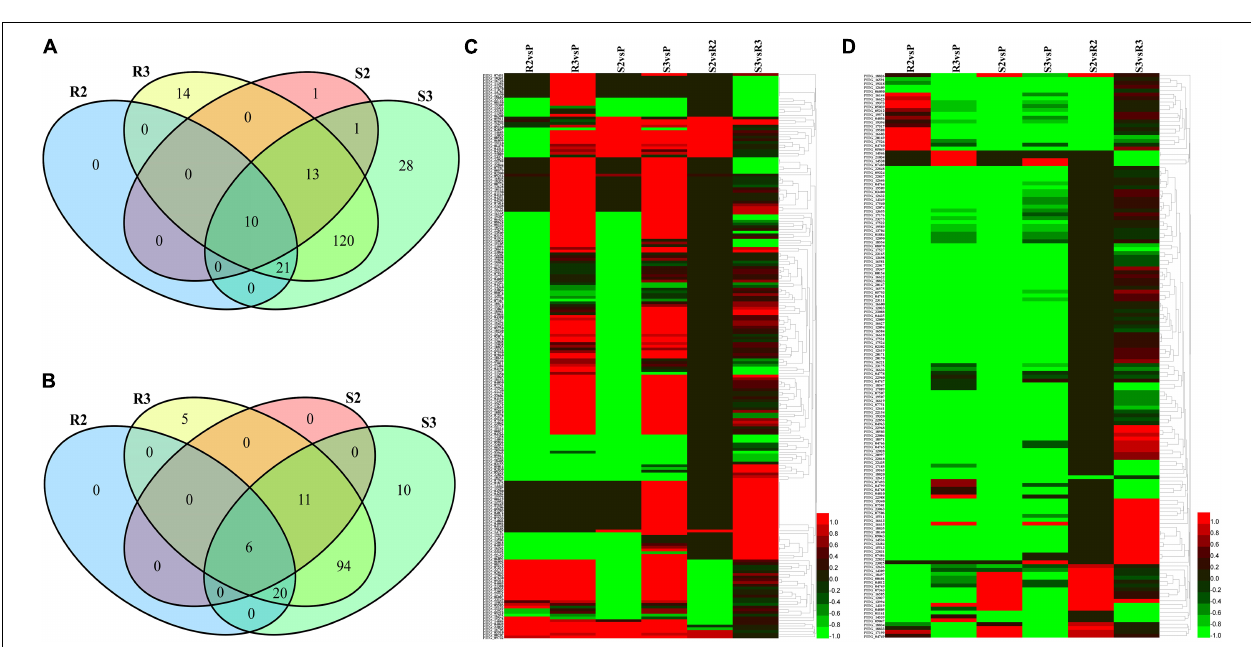
FIGURE 3 | Expression trend of the potato SEGs identified from incompatible interaction. The 1,180 SEGs were identified in Ziyun No.1 when compared with the susceptible cultivar Favorita. Trend analyses were performed based on the expression levels of the 1,180 SEGs at 0 hbi, 24 hpi, and 48 hpi using the OmicShare tools, a free online platform for data analysis (https://www.omicshare.com/tools).